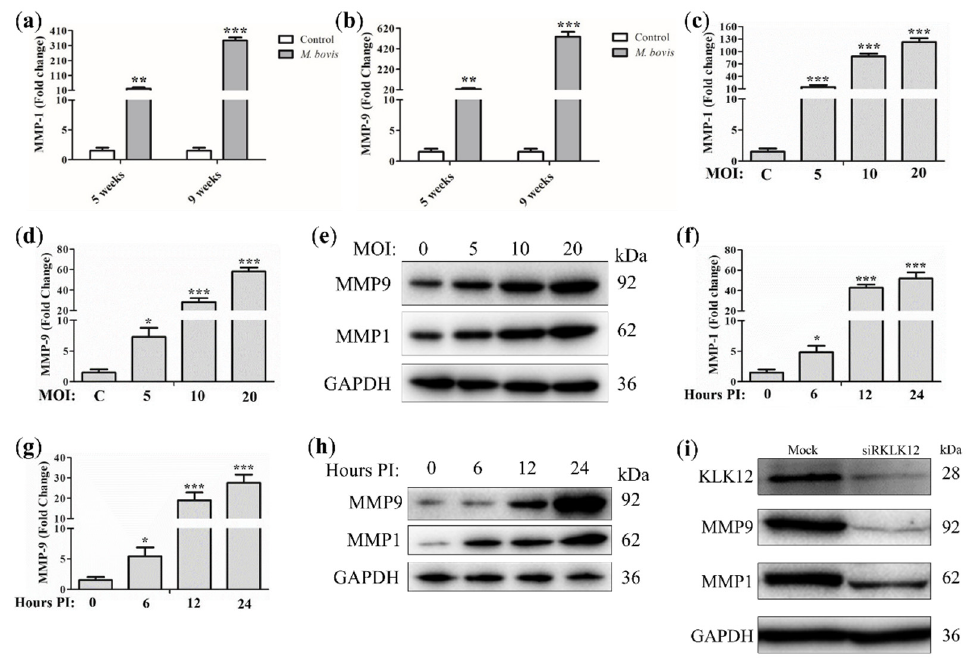
Figure 1. Knockdown of KLK12 downregulates expression of MMP-1 and MMP-9 in M. bovis -in- fected RAW264.7. Mice ( n = 10) were intranasally infected with M. bovis C68004 (at a dose of 200 CFU/mouse) or with PBS. Mice were sacrificed after 5 and 9 weeks of infection, and lung tissues were collected. ( a ) MMP-1 and ( b ) MMP-9 expression levels were determined by Quantitative Real-Time PCR (qRT-PCR). RAW264.7 cells were infected with M. bovis C68004 at variable MOIs (5, 10, and 20) and incubated for 24 h. MMP-1 and MMP-9 expression levels were determined by ( c , d ) qRT-PCR and ( e ) Western blot. Next, RAW264.7 cells were infected with M. bovis C68004 at an MOI of 10 and incubated for indicated periods, i.e., 0, 6, 12, and 24 h. MMP-1 and MMP-9 expression levels were determined by ( f , g ) qRT-PCR and ( h ) Western blot. KLK12 was then knocked down in M. bar graph represent the mean ± SD of three independent in vitro experiments (* p < 0.05; ** p < 0.01; *** p < 0.001).